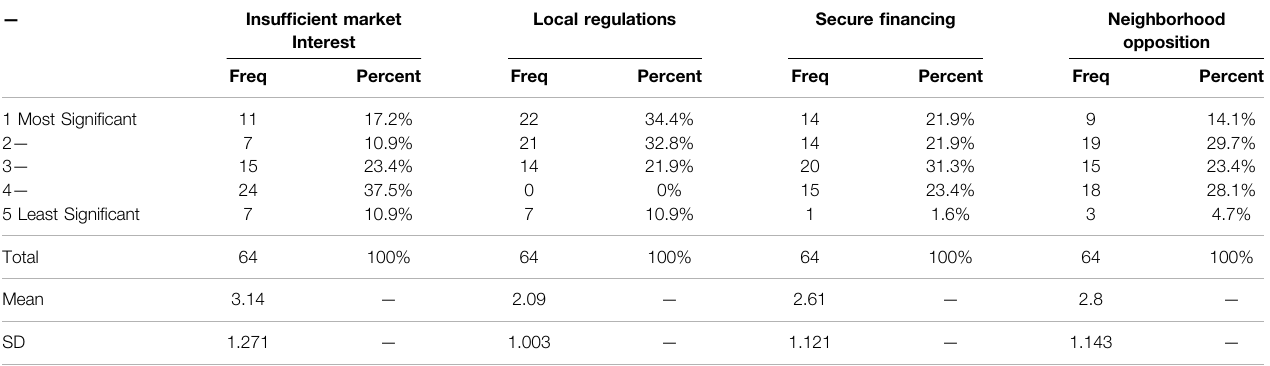
TABLE 9 | Current frequencies of challenges rankings. —